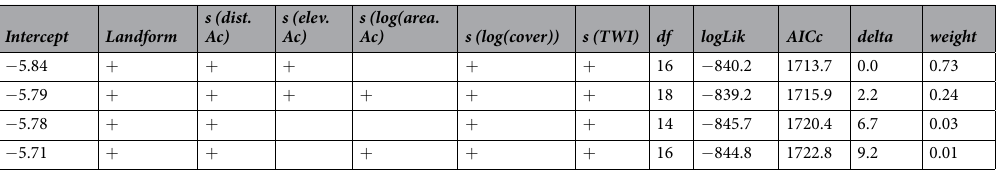
Table 1. Results of a model selection procedure, ranked by AICc, showing the four models with strongest support. A plus sign indicates the inclusion of the smoother (s()) or the categorical predictor (landform class), respectively, in the candidate model. dist.Ac , elev.Ac , area.Ac – distance to, elevation relative to, and area of the closest Acacia longifolia canopy; cover – vegetation cover + 1, TWI – topographic wetness index; logLik – log likelihood; AIC c - Akaike Information Criterion with finite sample correction; delta – difference in AIC c with respect to the lowest AIC c ; weight – AIC c weight (corresponds to the conditional probability of each candidate